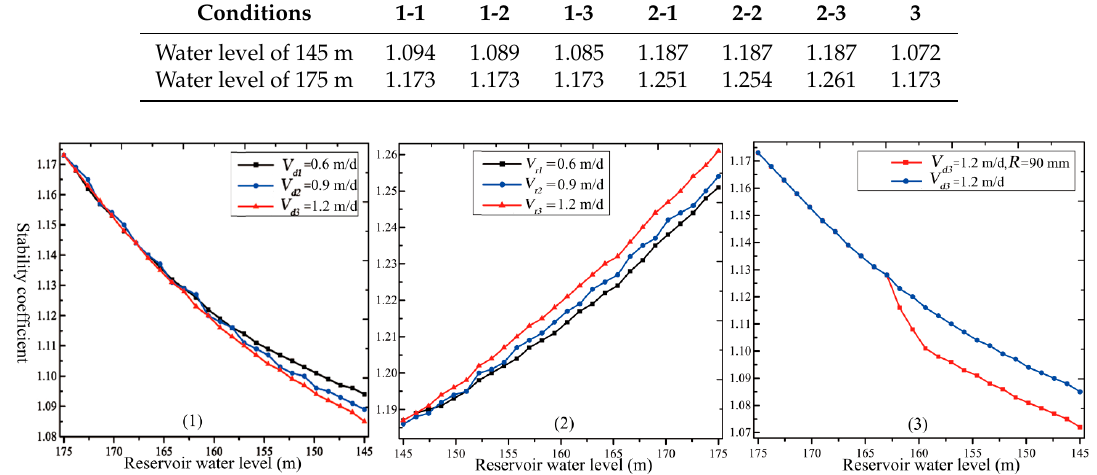
Table 3. Stability coefficient at water levels of 145 m and 175 m under different conditions.